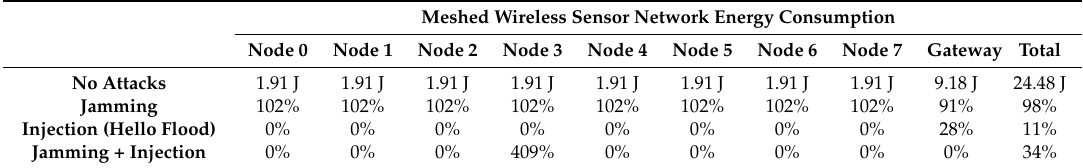
Table 4. Energy Consumption estimations for Meshed Network.